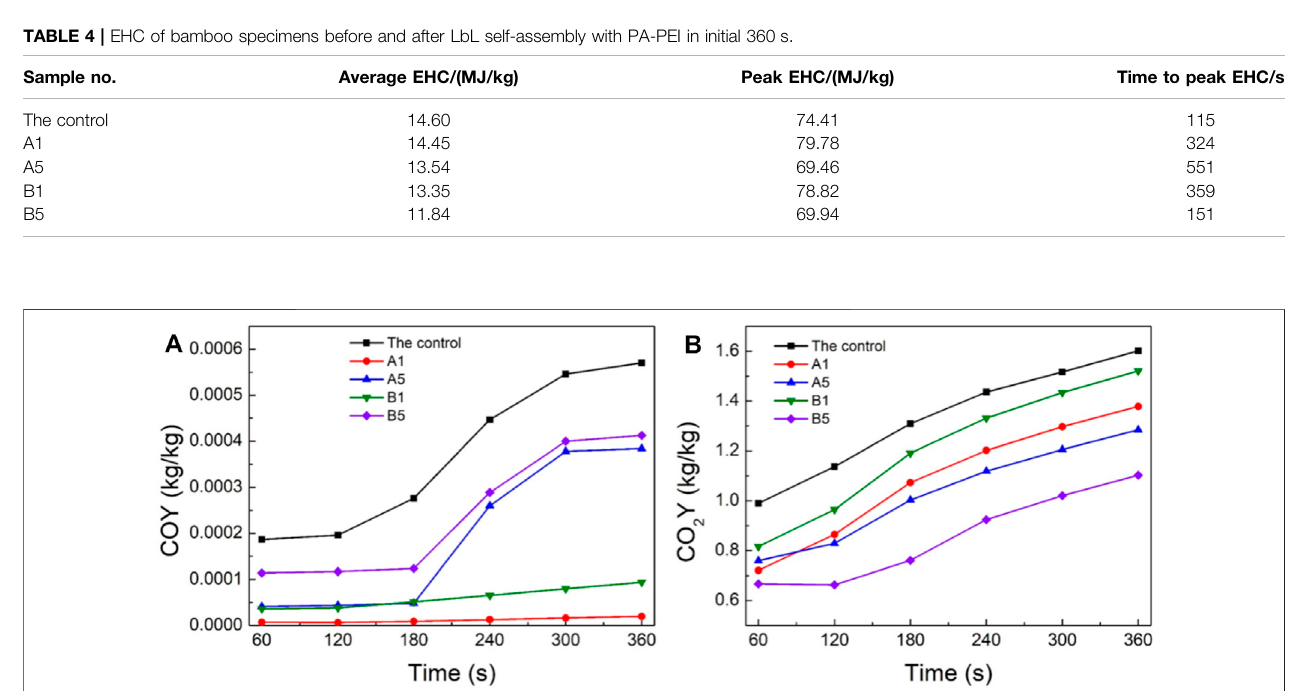
Frontiers in Materials |